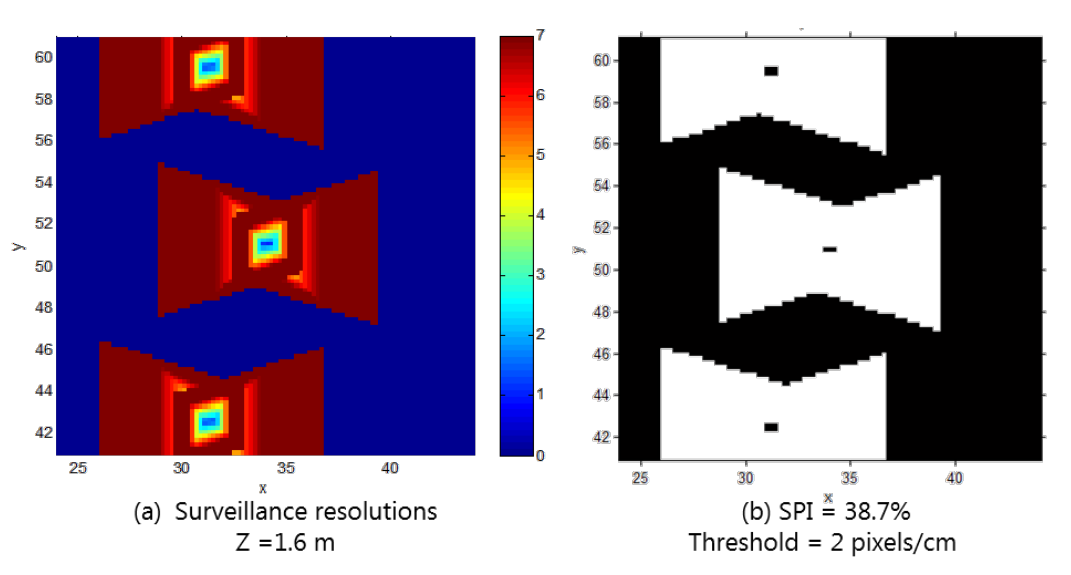
Figure 11. ( a ) Surveillance resolutions when objects are at 1.6 m height and their orientations are in the direction in which the maximum resolution is achieved; ( b ) Surveillance coverage index with a threshold of 2 px/cm (after adding two